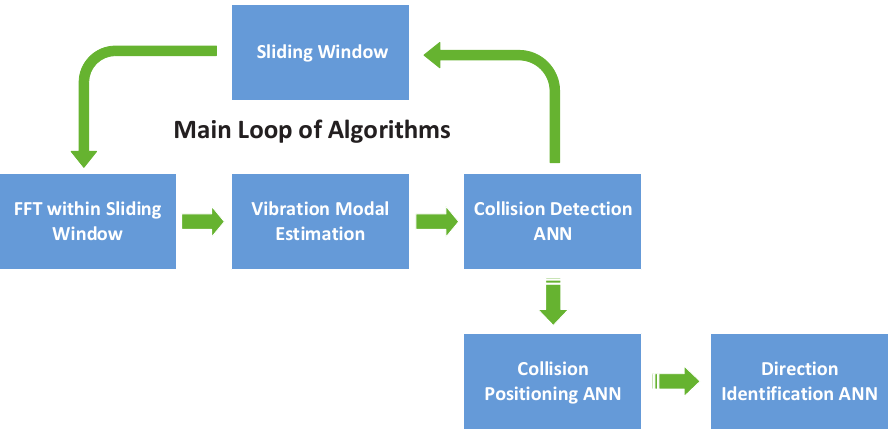
Figure 7. Procedure of detection algorithm.